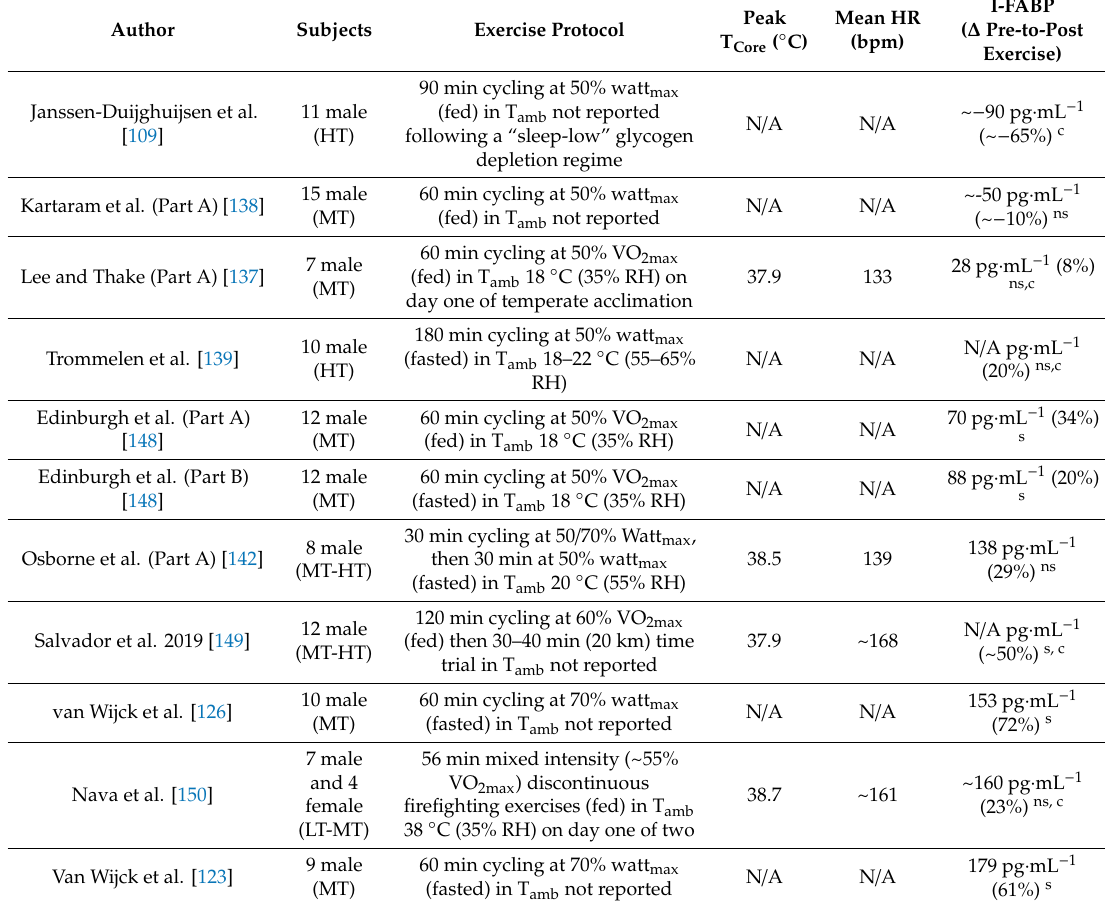
Table 3. Influence of acute exercise-(heat) stress on systemic I-FABP